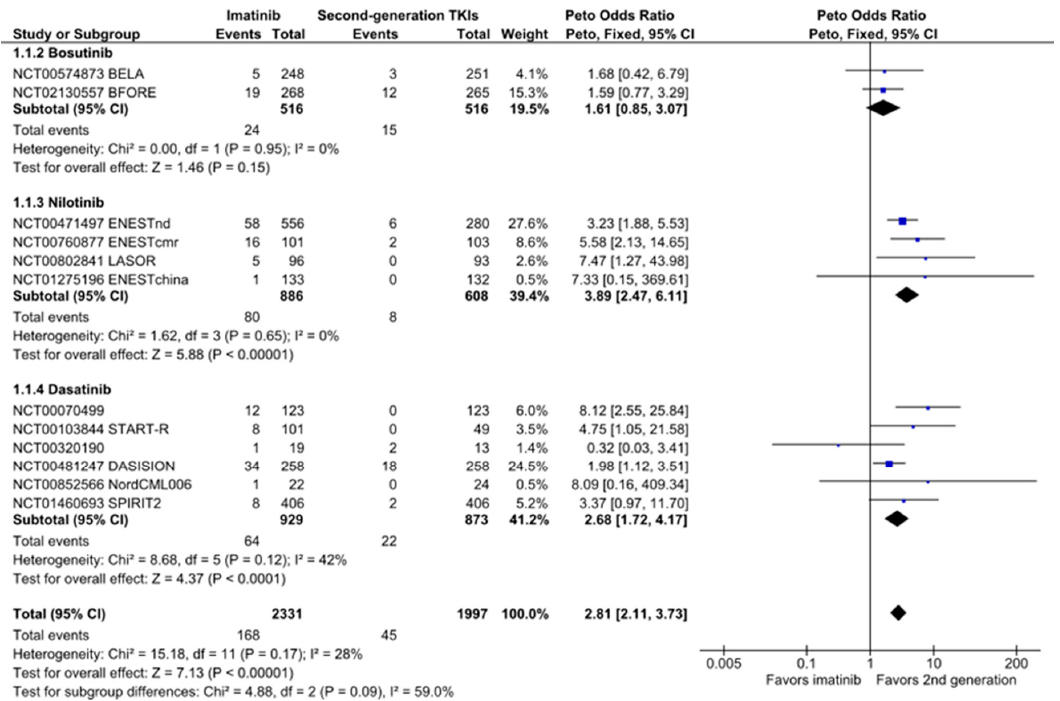
Figure 3. Forest plot of arterial occlusive events in patients with CML treated with second-generation TKIs versus imatinib.